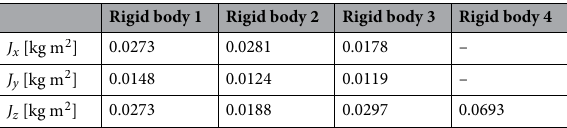
Table 1. Moments of inertia of the CMG.